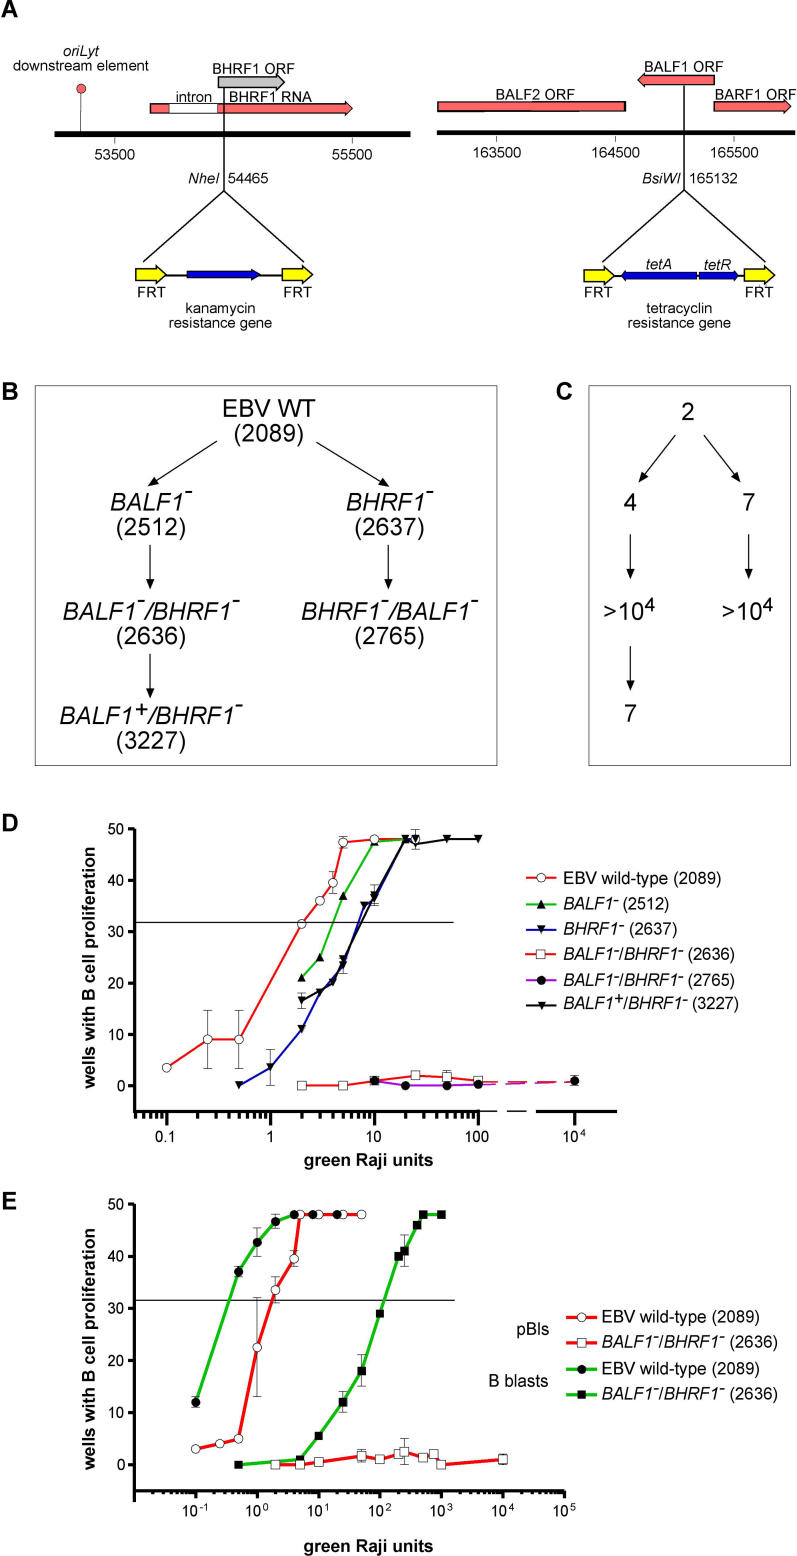
Construction and Genealogy of EBV Mutants and Their Efficiency of B-Cell Growth Transformation(A) Construction of the loss of function mutation in BALF1 and BHRF1. (B) Wild-type (WT) 2089 EBV is based on the genome of the EBV strain B95.8. The BALF1 and BHRF1 genes were inactivated through insertional mutagenesis with antibiotic resistance genes. Two vBcl-2 mutants 2636 and 2765 were constructed independently on the basis of the singly inactivated viruses, and the BALF1−/BHRF1− mutant 2636 was reverted to BALF1+/BHRF1−. (C) The numbers indicate the number of GRUs of the virus stocks, which were required to yield one clonal LCL for each virus noted in (B). (D) Efficiency of B-cell growth transformation. The different singly and dually vBcl-2− EBV virus mutants were compared with wild-type 2089 EBV for their efficiencies to growth transform primary B cells in limiting dilution assays. Forty-eight wells with 105 target B cells per well were infected with each virus dilution, and wells with proliferating cells were recorded 6 wk p.i. The data are graphed to identify the number of GRUs of the different virus isolates required to yield one LCL. The horizontal line at 30 wells positive for 48 wells plated identifies for a Poisson distribution the required number of GRUs shown on the x-axis. Infection of primary B cells with the vBcl-2− mutants 2636 and 2765 did not yield stable LCLs even with up to 104 GRUs per 105 cells per well. (E) Comparison of the efficiency of wild-type 2089 EBV and the BALF1−/BHRF1− mutant 2636 to yield stable, clonal LCLs in limiting dilution assays with primary B cells or activated B blasts as target cells. Activated B blasts readily gave rise to LCL clones with the BALF1−/BHRF1− mutant 2636 in contrast to the situation in (D), although about 200 GRUs were statistically required to establish clonal lines, which all could be further expanded and characterized (data not shown).